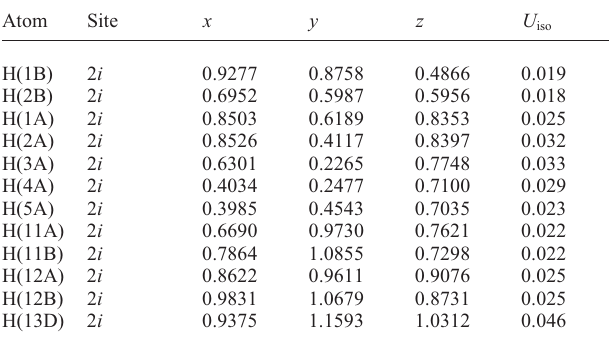
Table 2. Atomic coordinates and displacement parameters (in Å 2 )